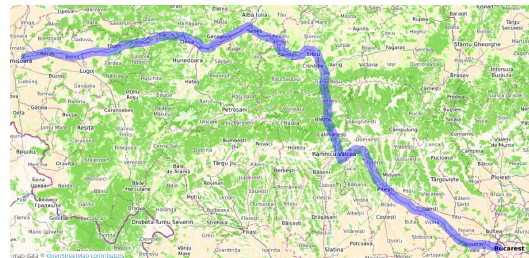
Figure 2. Romanian Carpathians A1-DN7 light intensity measurement